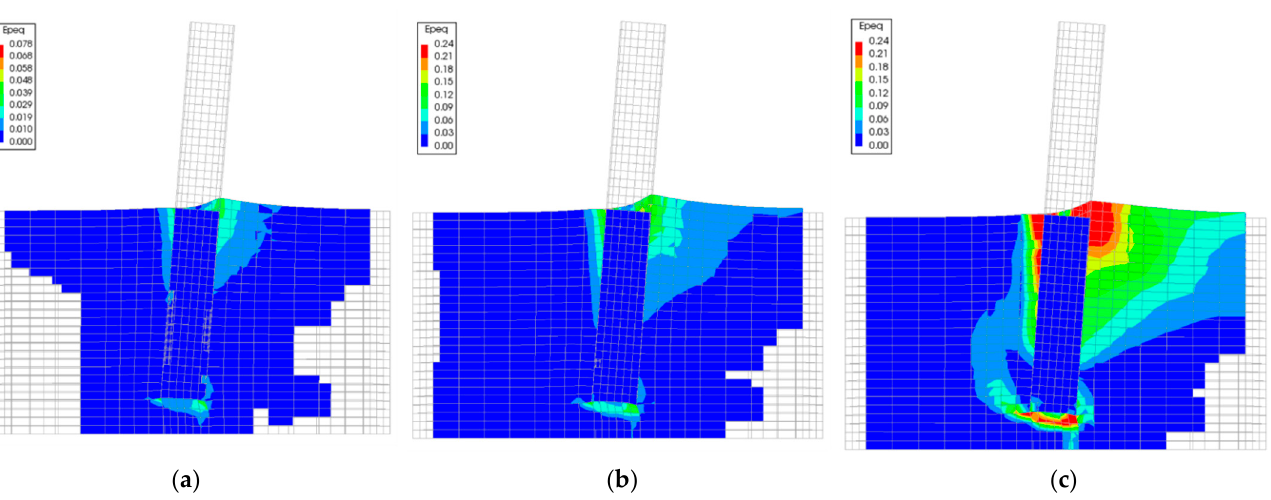
Figure 8. Failure of monopile foundation: ( a ) initial loading ( δ = 5 mm); ( b ) peak load ( δ = 30 mm); ( c ) residual state ( δ = 80 mm); where δ : lateral displacement at the top of the monopile, Epeq: equivalent plastic strain (mm/mm).